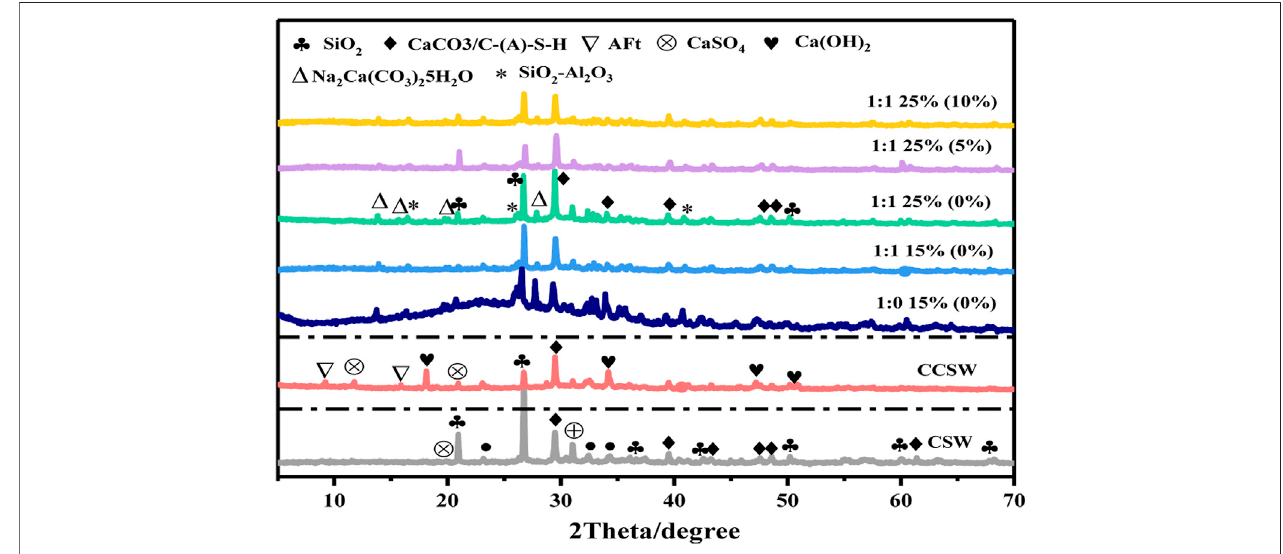
FIGURE 7 | XRD for CCSW and GCSW composite.